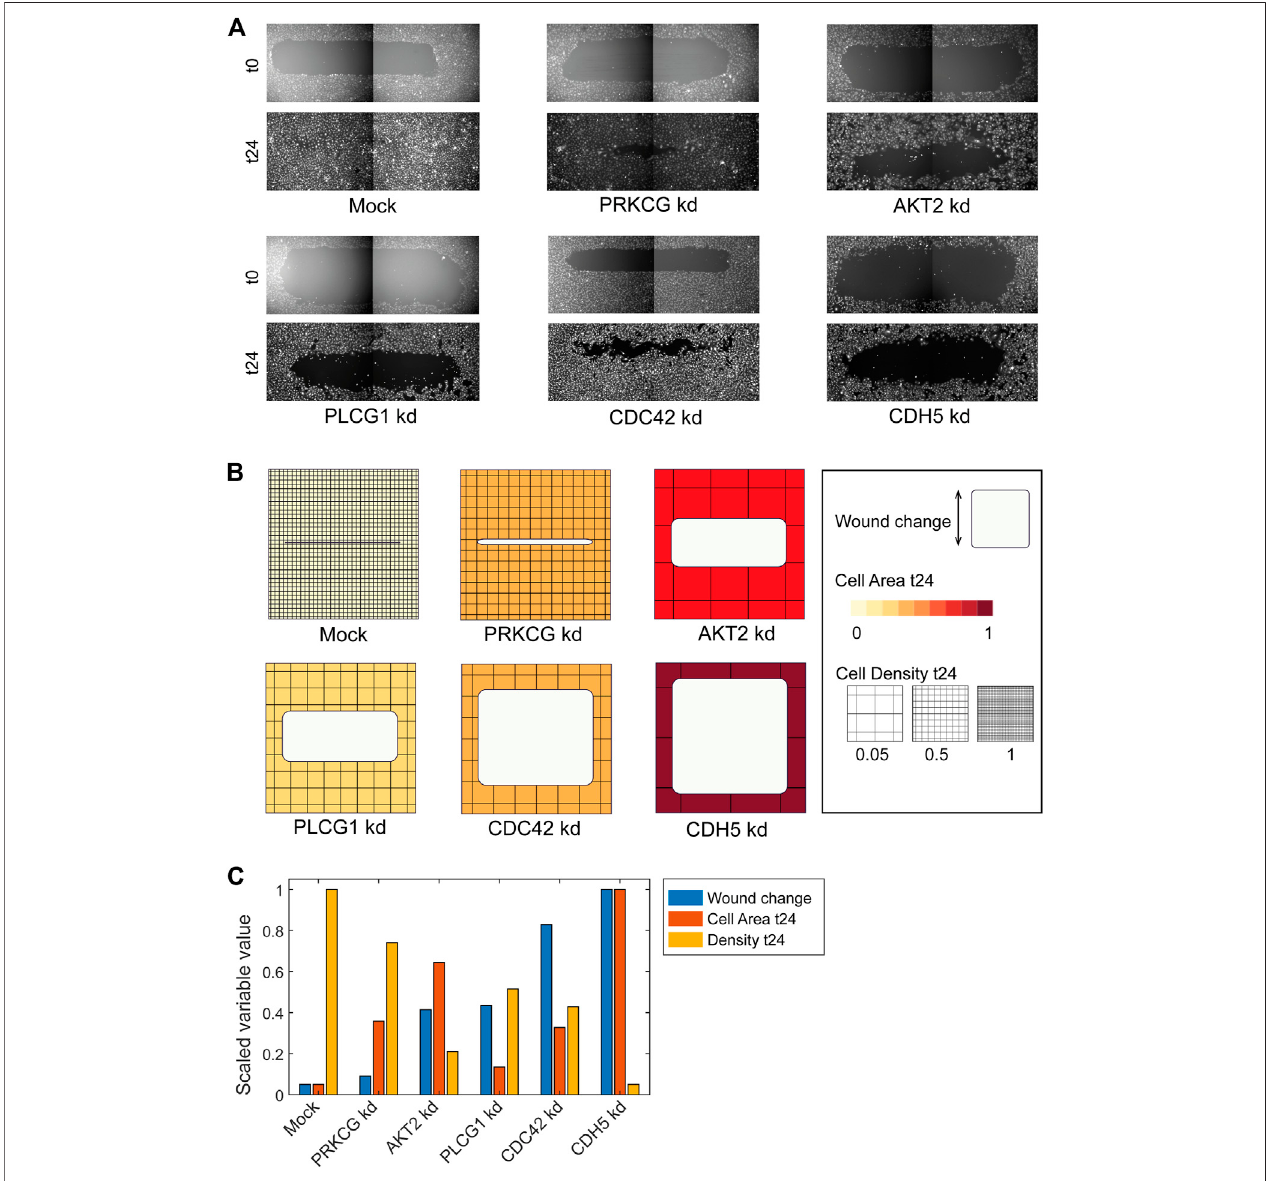
FIGURE 3 | Using ShapoGraphy to represent wound healing data. (A) Image data capturing the effect of various gene depletions on human lymphatic endothelial cells ability to migrate into scratch wounds [time-point 0h (t0) and 24h (t24)]. (B) Intuitive representation of wound area and cell number measurements using ShapoGraphybasedondatain (A) .Theoutersquarerepresentsthewellwherelighterredhuesindicatelowercellareawhilehigherredhuesindicatehighercellarea.Cell numberismappedtogriddensity.Theheightoftheinnersquarerepresentsthenormalisedchangeinwoundarea. (C) Representationofthesamedatain (B) using a bar chart where numerical data are mapped to the bars ’ length